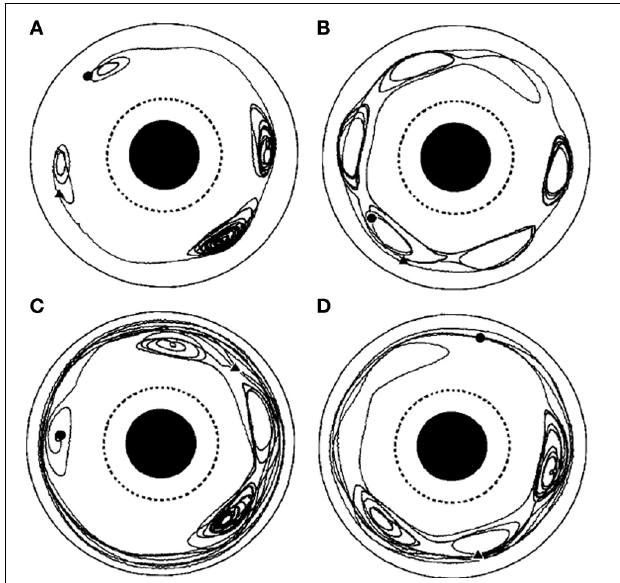
FIGURE 10 | From the original; Chaotic particle trajectories in a time-periodic flow. (A–D) Depict different runs of the apparatus with different numbers and locations of vortices. From the original; Chaotic particle trajectories in a time-periodic flow. Long sticking events can be seen in each case, and flights of length greater than one rotation about the annulus can be seen in (C) , (D) . Hyperbolic fixed points, near which the particle motion is particularly sensitive to transitions between flights and sticking events, are evident in all the trajectories. The particle motion is viewed from a reference frame that is co-rotating with the vortex chain, and the beginning of each trajectory is marked by a circle, the end by a triangle. From Solomon et al. (1994), copyright American Physical Society 1994.